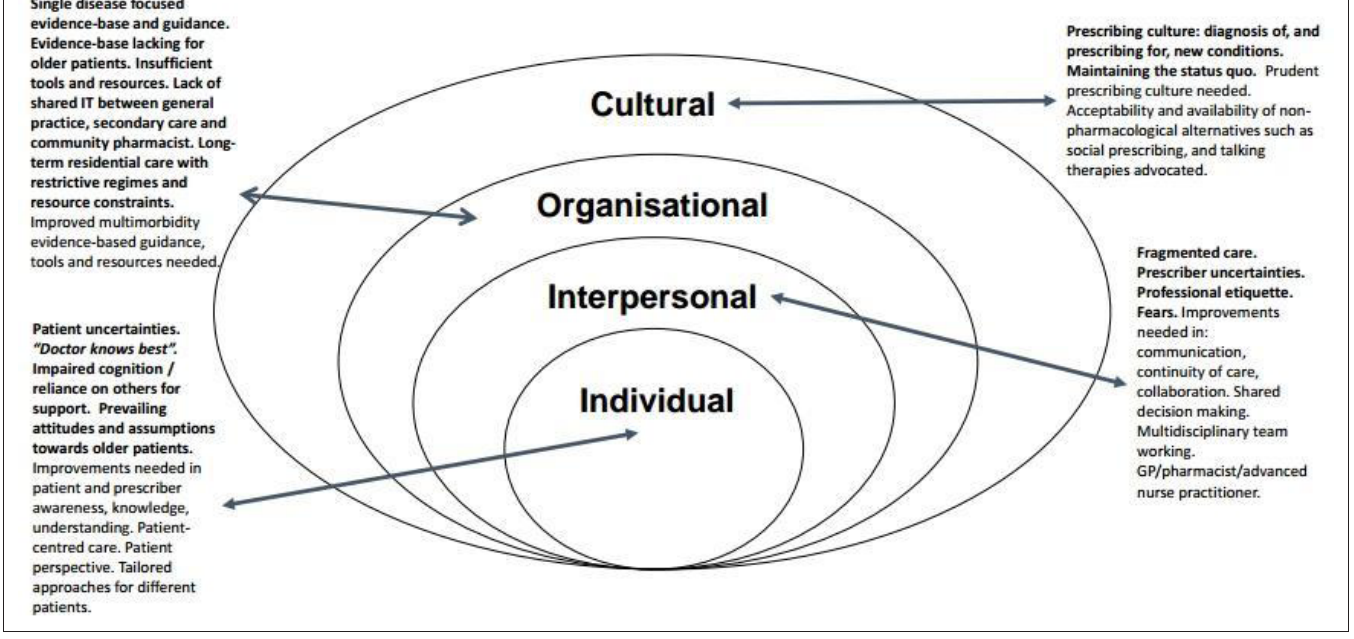
Figure 2 Socio- ecological approach to understanding barriers and facilitators to deprescribing in primary care for patients with multimorbidity and